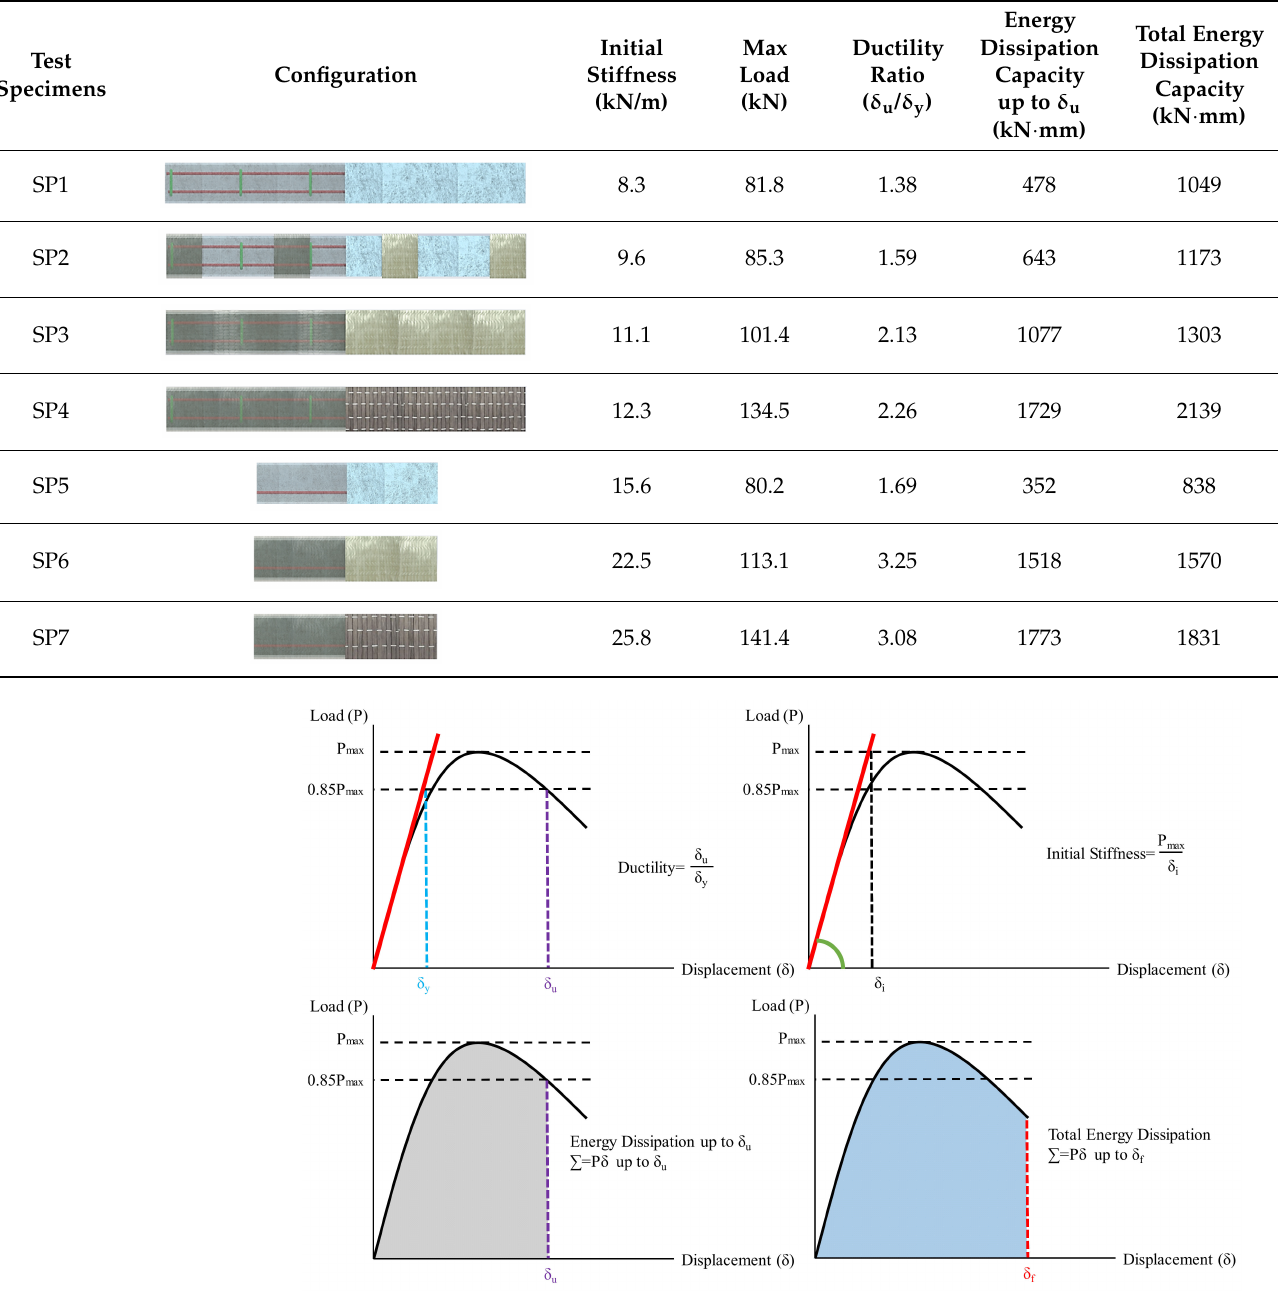
Figure 6. Calculation of the ductility, initial stiffness and energy